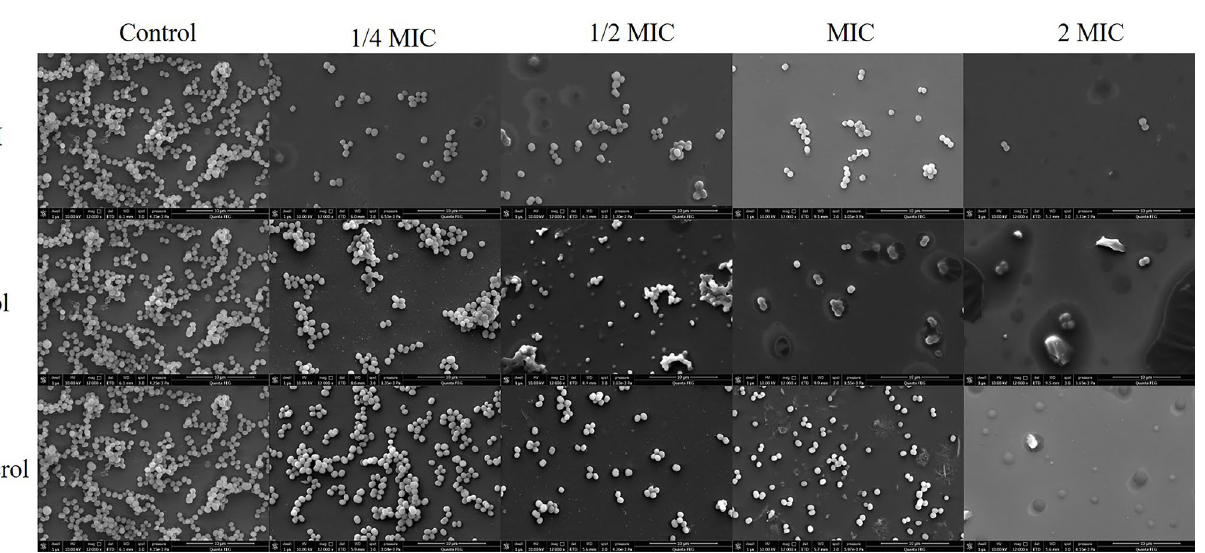
Figure 7. Effect of EOCM, thymol and carvacrol the growth of S. aureus biofilm and bacterial mor- phology (SEM, ×12,000). morphology (SEM, ×